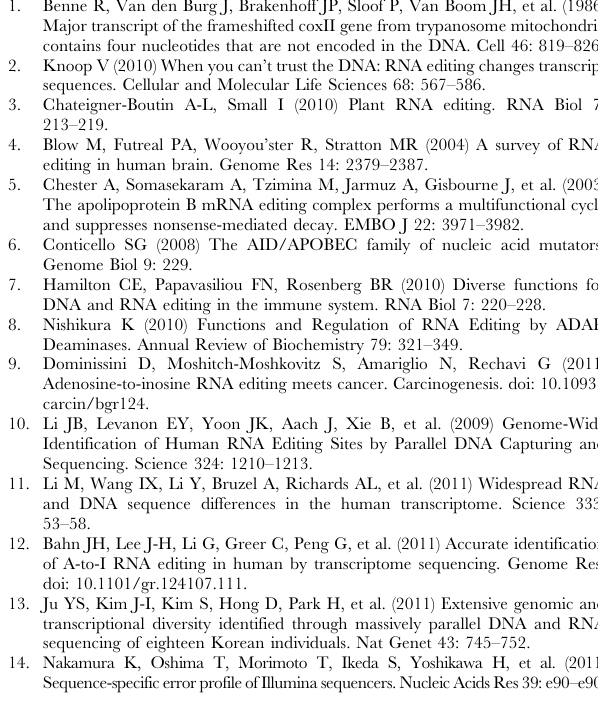
Figure S6 Motifs discovered at or near strand biased